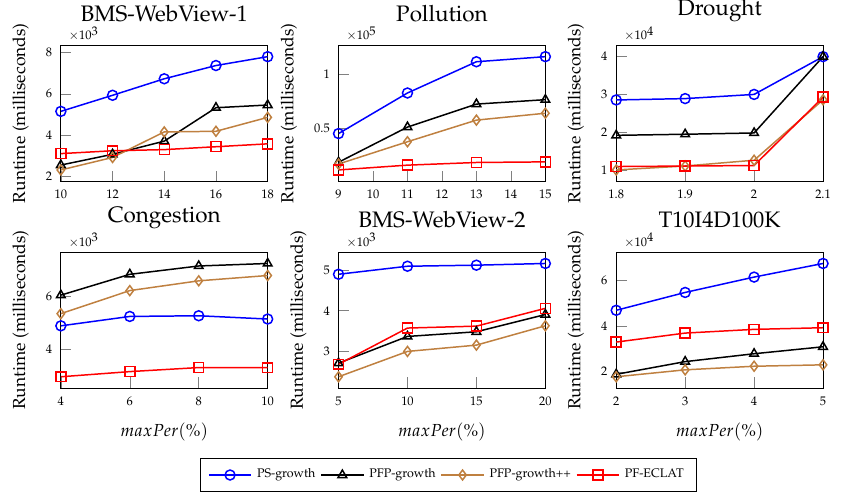
Figure 4. Runtime evaluation of algorithms at constant minSup